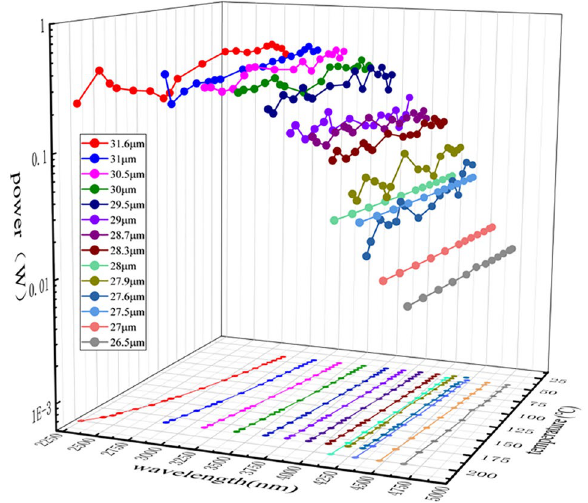
Figure 4. Curves of tuning temperature and periods. Span of idler is from 2.25 to 4.79 μm when pump power is 4.8 W. The temperature is from 40 °C to 200 °C. (Origin 2018, https ://www.origi nlab.com/, Adobe Photoshop CC 2018, https ://www.adobe .com/cn/produ cts/photo shop.html/).